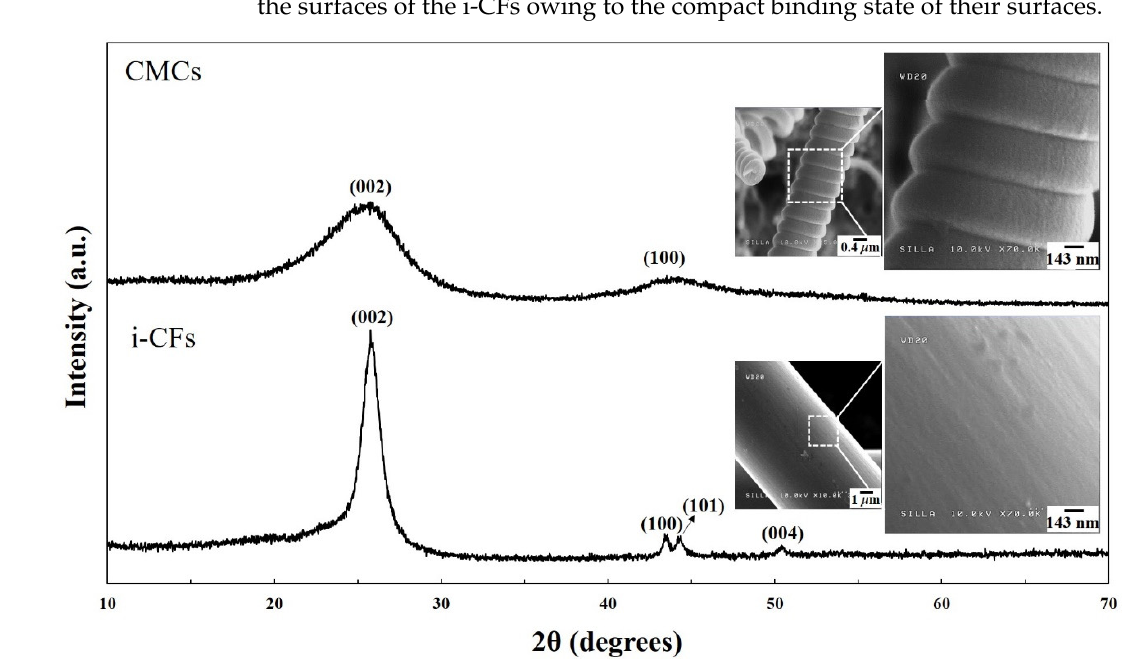
Figure 6. XRD patterns and FESEM images of the CMC and i-CF surfaces.